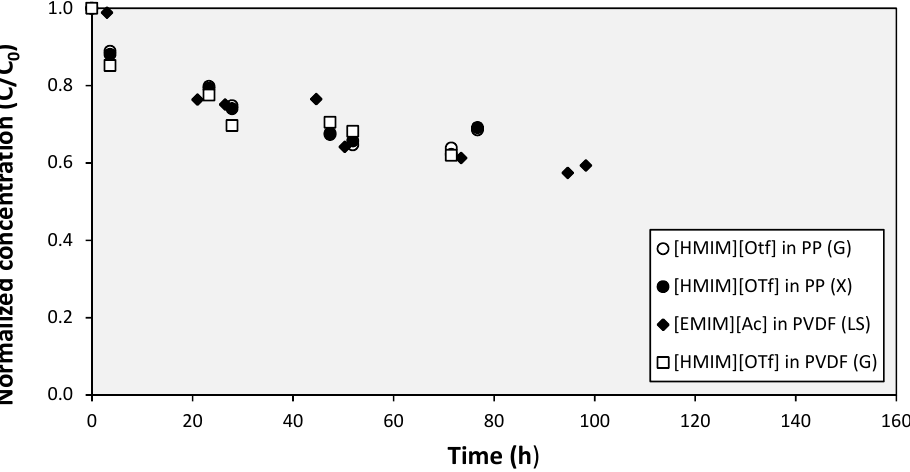
Figure 10. Evolution of the concentration of lignosulphonate (LS), glucose (G), or xylose (X) in the feed compartment with three different SILMs.